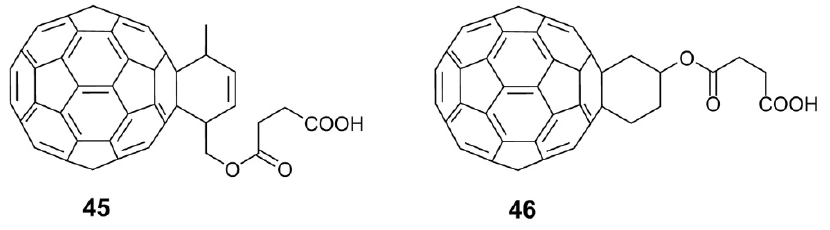
Figure 12. Structural diagram of carboxylic fullerene derivatives ( 45 – 46 ).